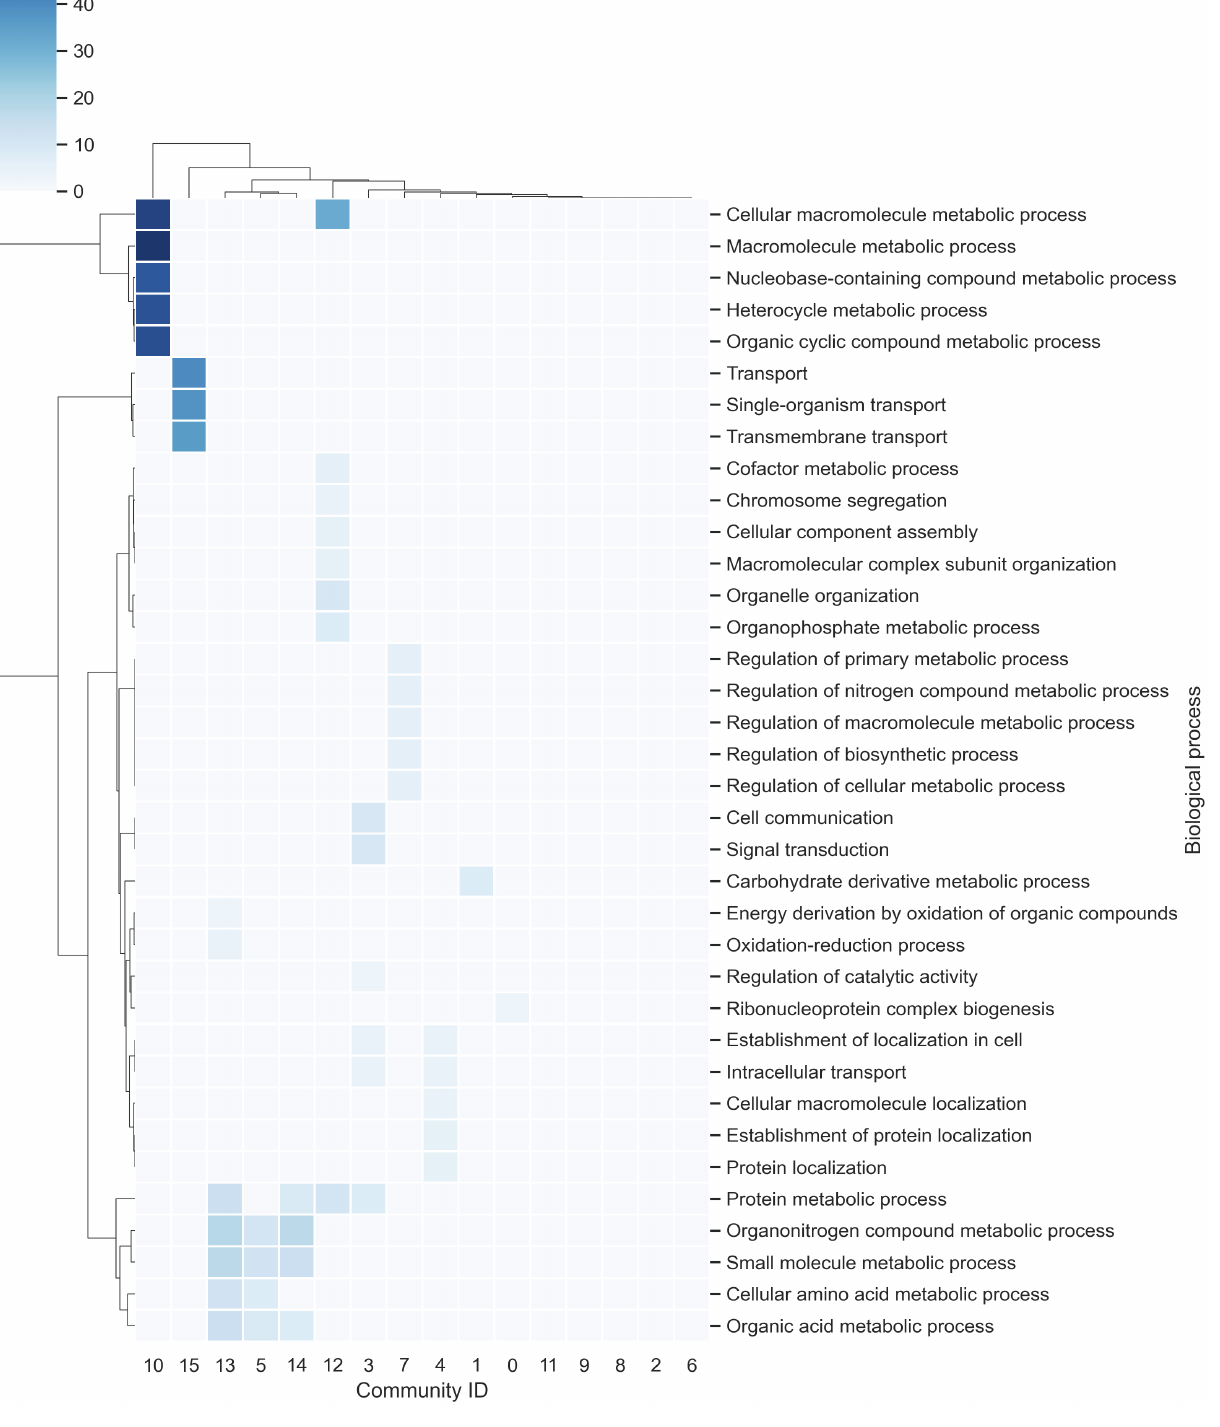
FIGURE 2 | Communities in the network. The richest biological processes for each community were identified and hierarchically clustered based on Euclidean distance measures and Ward’s method for linkage analysis. Each row represents the gene ontology (GO) term for a biological process, and each column represents the community